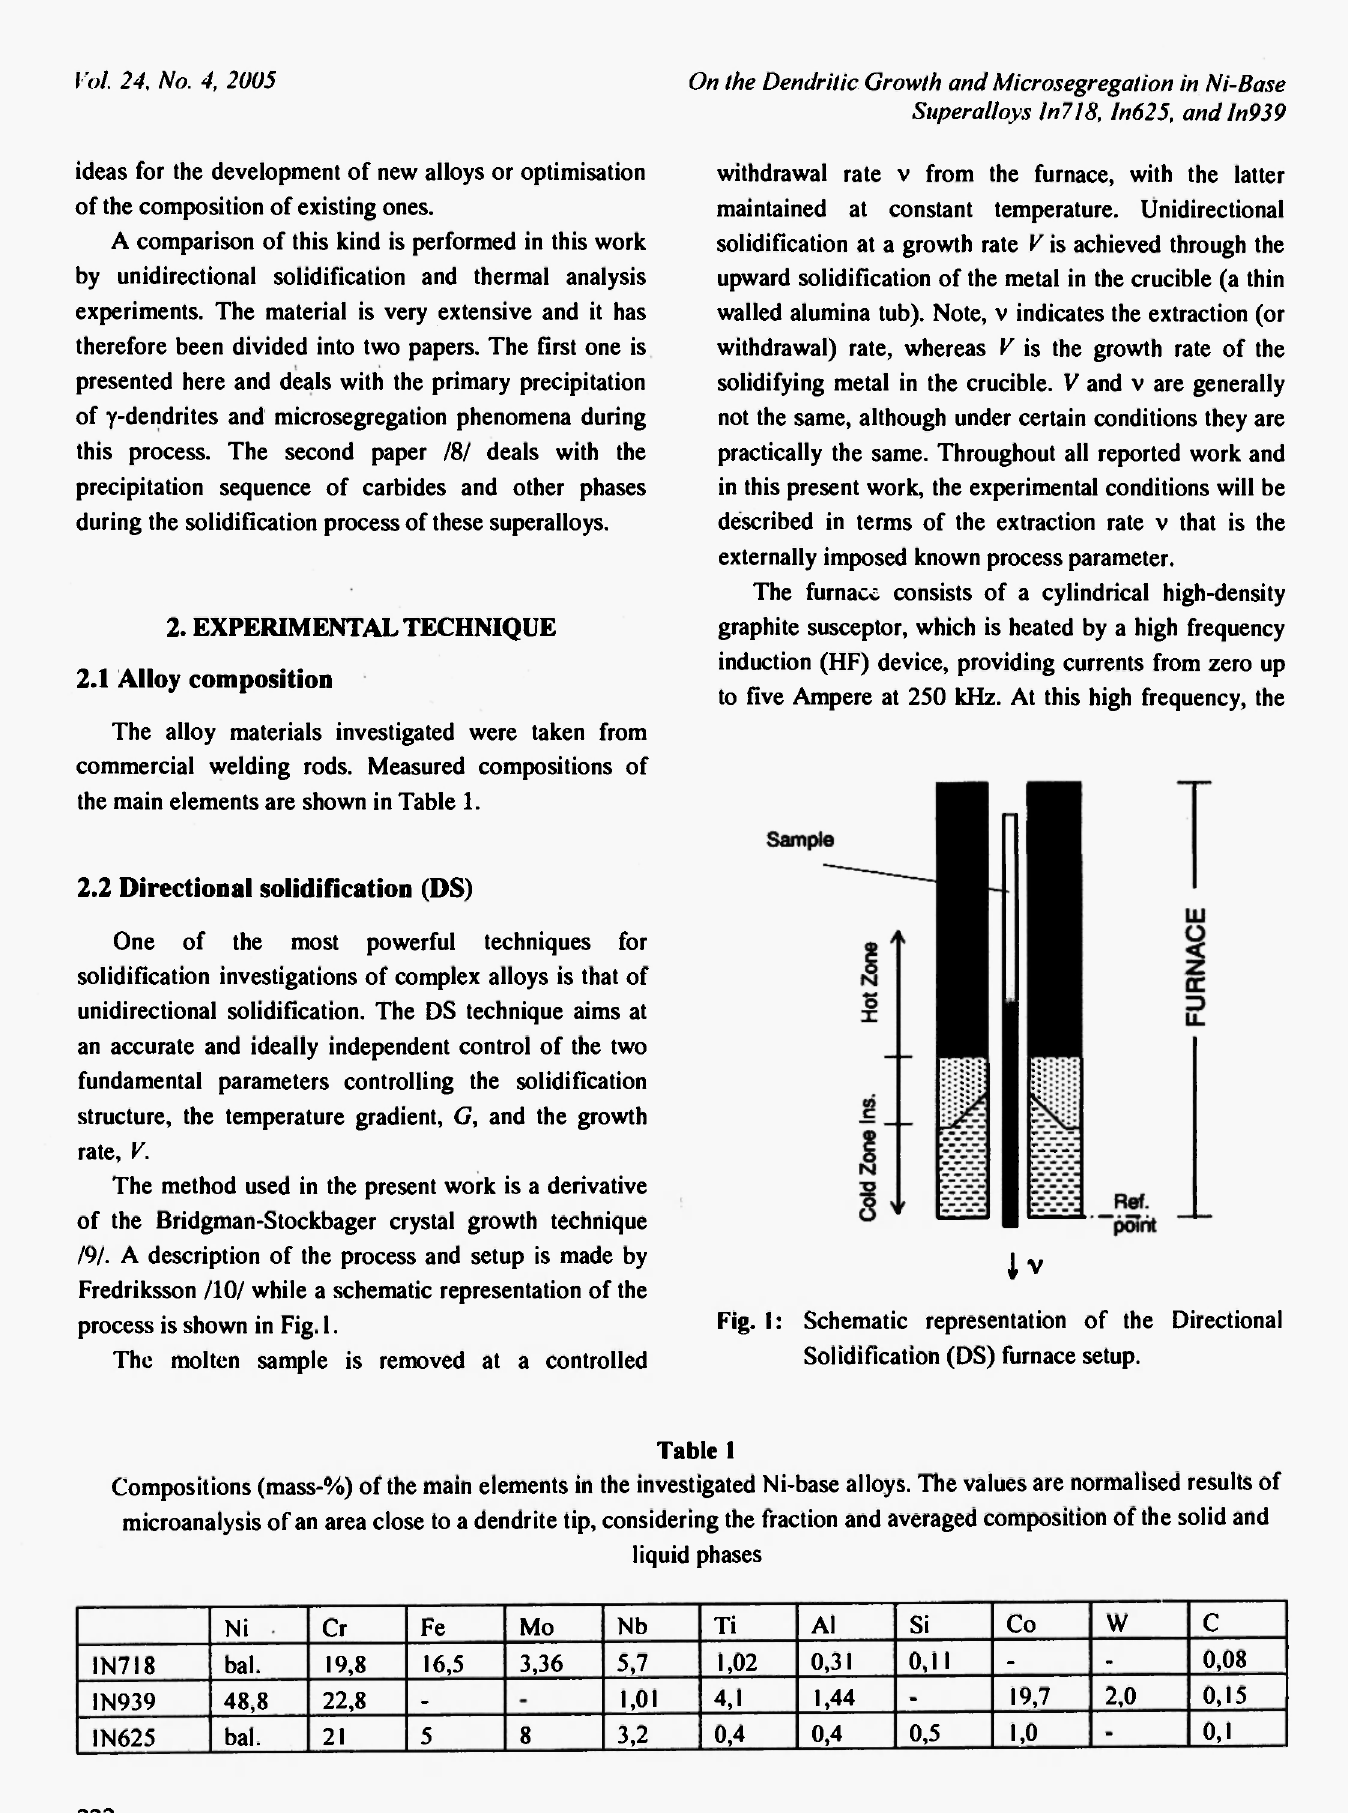
Fig. I: Schematic representation of the Directional Solidification (DS) furnace